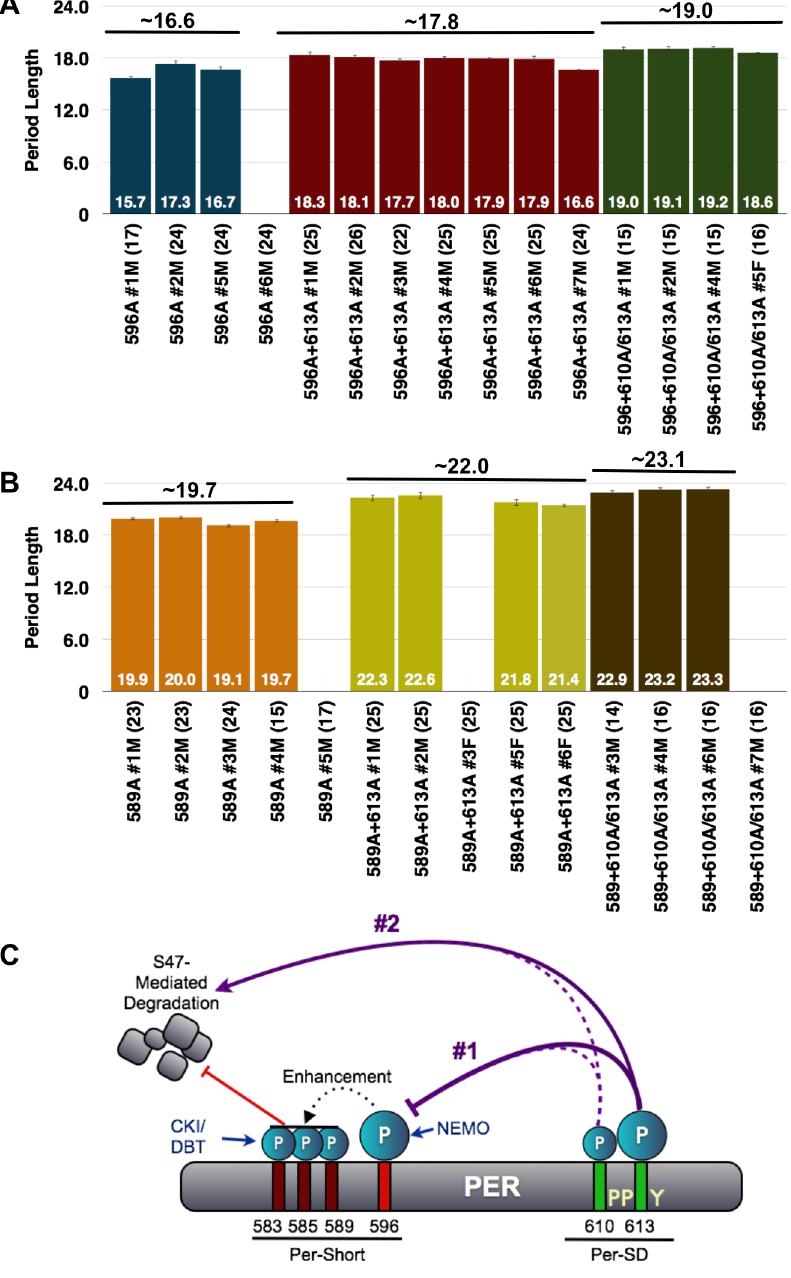
Figure 8. The short period phenotype of S596A is epistatic to S613A. ( A ) Graphs depicting period length of per 01 flies carrying transgenes harboring the single S596A mutation (blue bars) or S596A combined with the S613A (red bars) or T610A/S613A (green bars) mutations. Period lengths are listed within each bar and values in parentheses indicate the number of flies analyzed. Average period length for all lines combined is listed above each set. Raw data are summarized in Table 1. Only male flies were analyzed in these experiments. Note, the S596A + S613A lines possess period lengths similar to those of S596A single mutant lines suggesting that S596A is largely epistatic to S613A; in other words, without S596, regulation by S613 is not critical. Additionally, S596A is also largely epistatic to the long period phenotype of the double T610A/S613A mutant. ( B ) The S613A (yellow bars) and T610A/S613A (brown bars) mutations are able to more dramatically increase the period length of the S589A mutation (orange bars), which is only one of three residues regulated by 596. These data are consistent with S613A regulating the more critical phospho- residue, S596. ( C ) Updated model representing potential regulation of PER by the PER-Short and PER-SD domains. In scenario # 1, the PER-SD domain regulates phosphorylation of residues within the PER-short domain, while scenario # 2 proposes that phosphorylation of the PER-Short and PER-SD domains control clock speed in parallel.